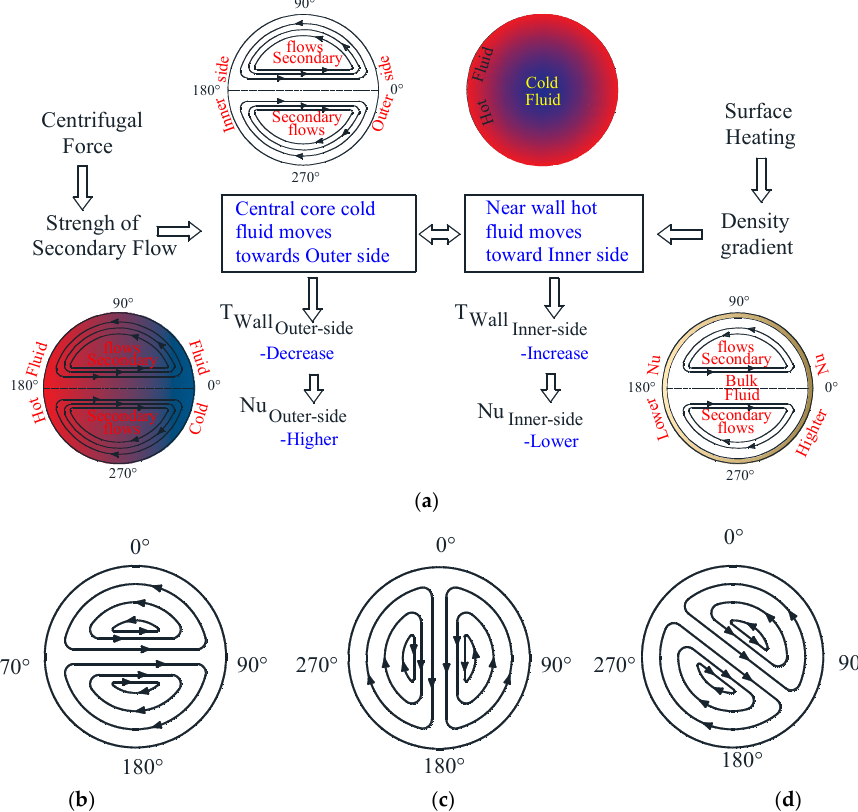
Figure 5. ( a ) Phenomenal chart for wall temperature and Nusselt number distribution caused by centrifugal force [58]; Schematic of secondary cross-section flow structures [49] caused by ( b ) only centrifugal force; ( c ) only buoyancy force; ( d ) combination effects of centrifugal and buoyancy force [49].